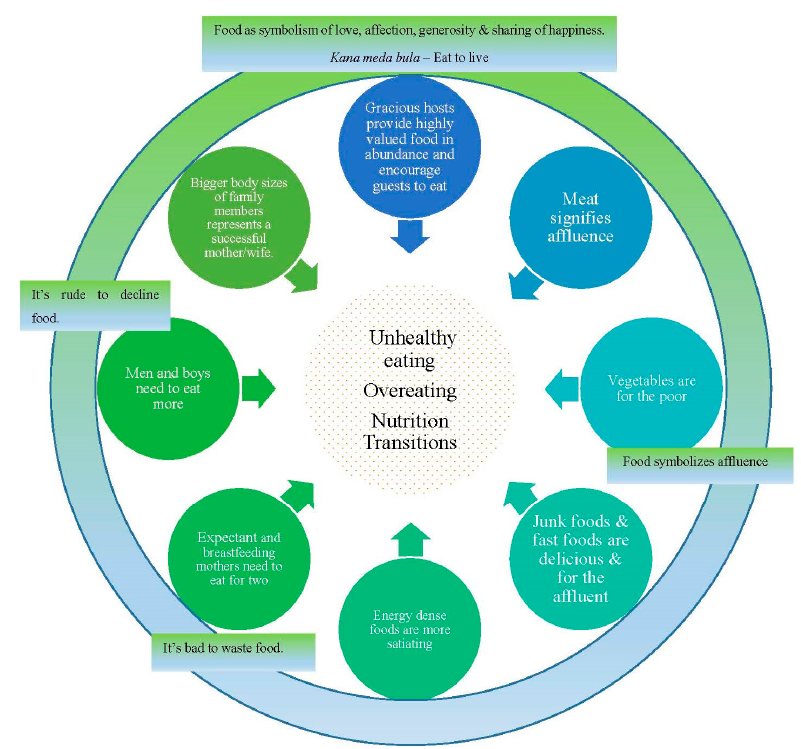
Figure 1. Thematic Figure 1. Thematic Map.